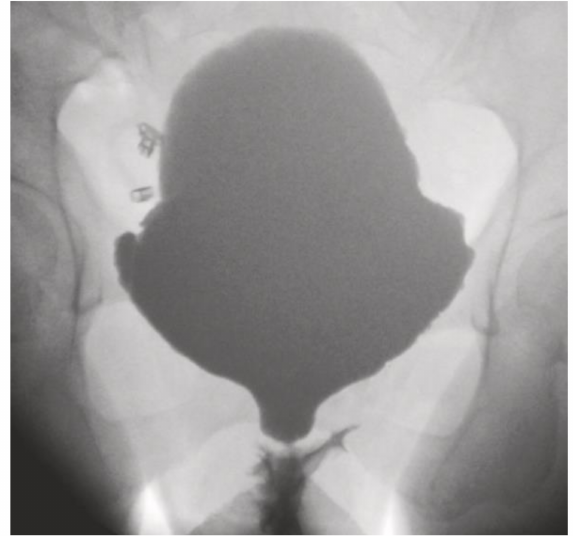
Figure 1. Voiding cystourethrography with a distal female urethral stricture and prestenotic dilation. Postoperatively, patients underwent a voiding cysto-urethrography upon catheter removal and were subsequently followed by uroflowmetry and measurement of the post void residual volume. Patency rate was defined as the absence of lower urinary tract symp- toms, a flow rate more than 15 mL/s and normal findings at voiding cysto-urethrography. Descriptive statistics were performed. Informed consents of all patients were